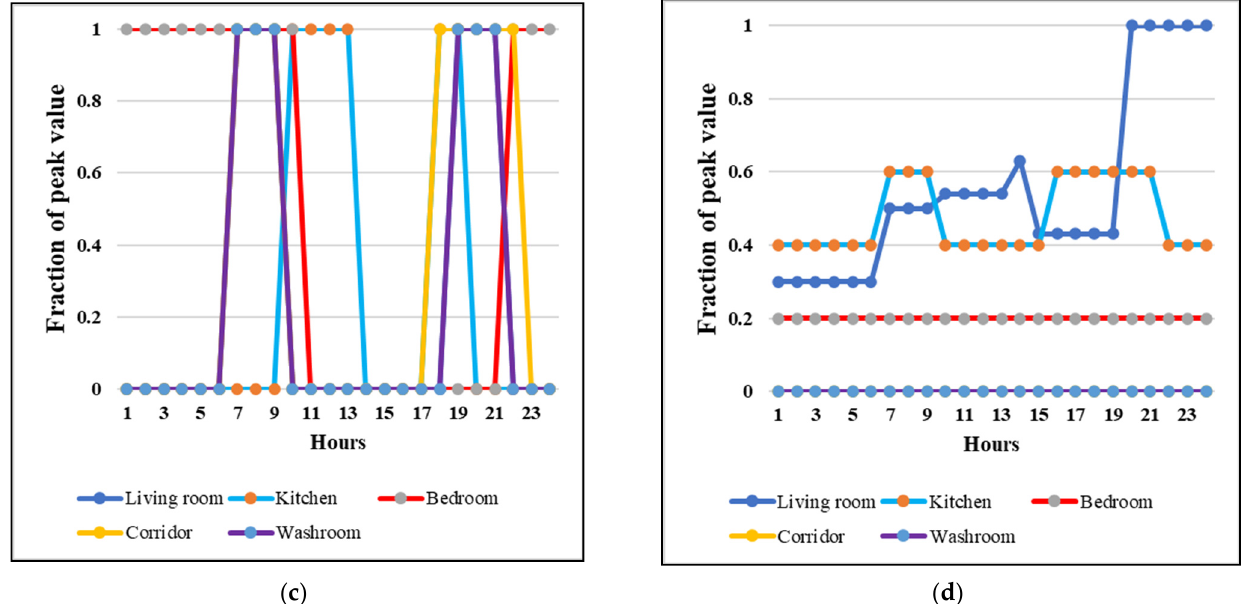
Figure 3. Weekday building schedules. ( a ) Occupancy schedule, ( b ) lighting schedule, ( c ) HVAC schedule, ( d ) equipment schedule.